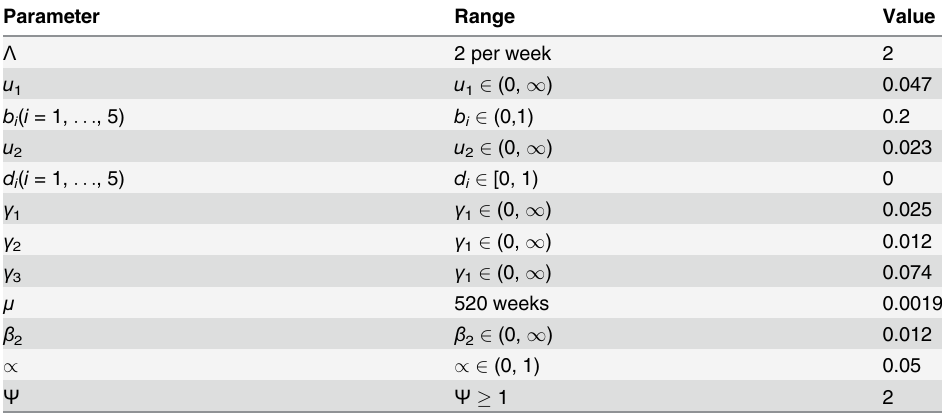
Table 1. The parameters of system Eq (1).